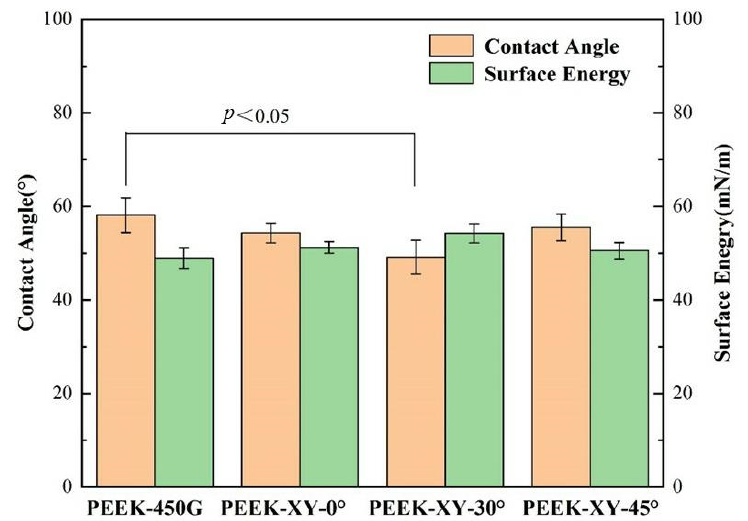
Figure 6. Contact angles and surface energy of PEEK 450G and FDM fabricated PEEK parts.